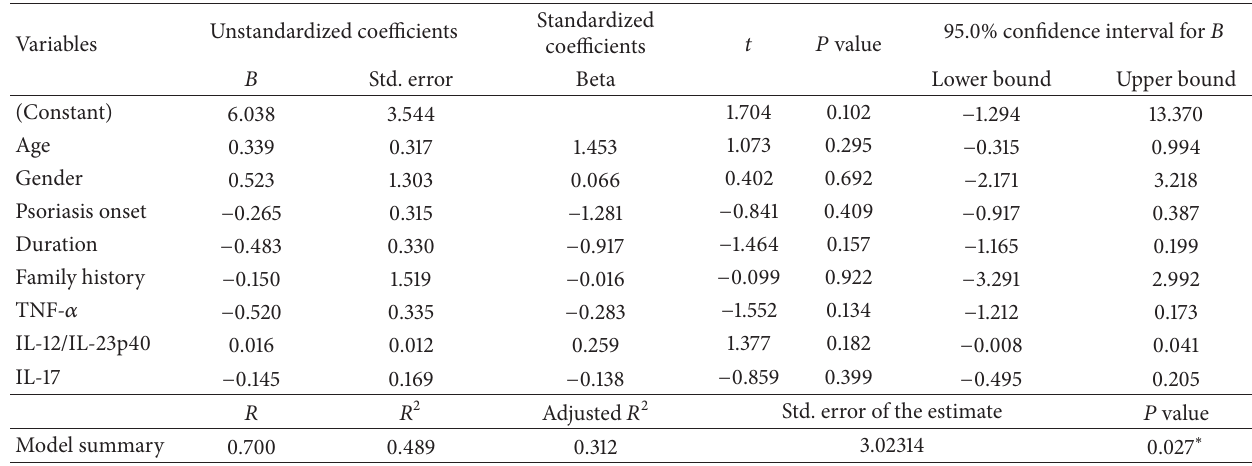
Table 4: Results of multiple linear regression analysis for